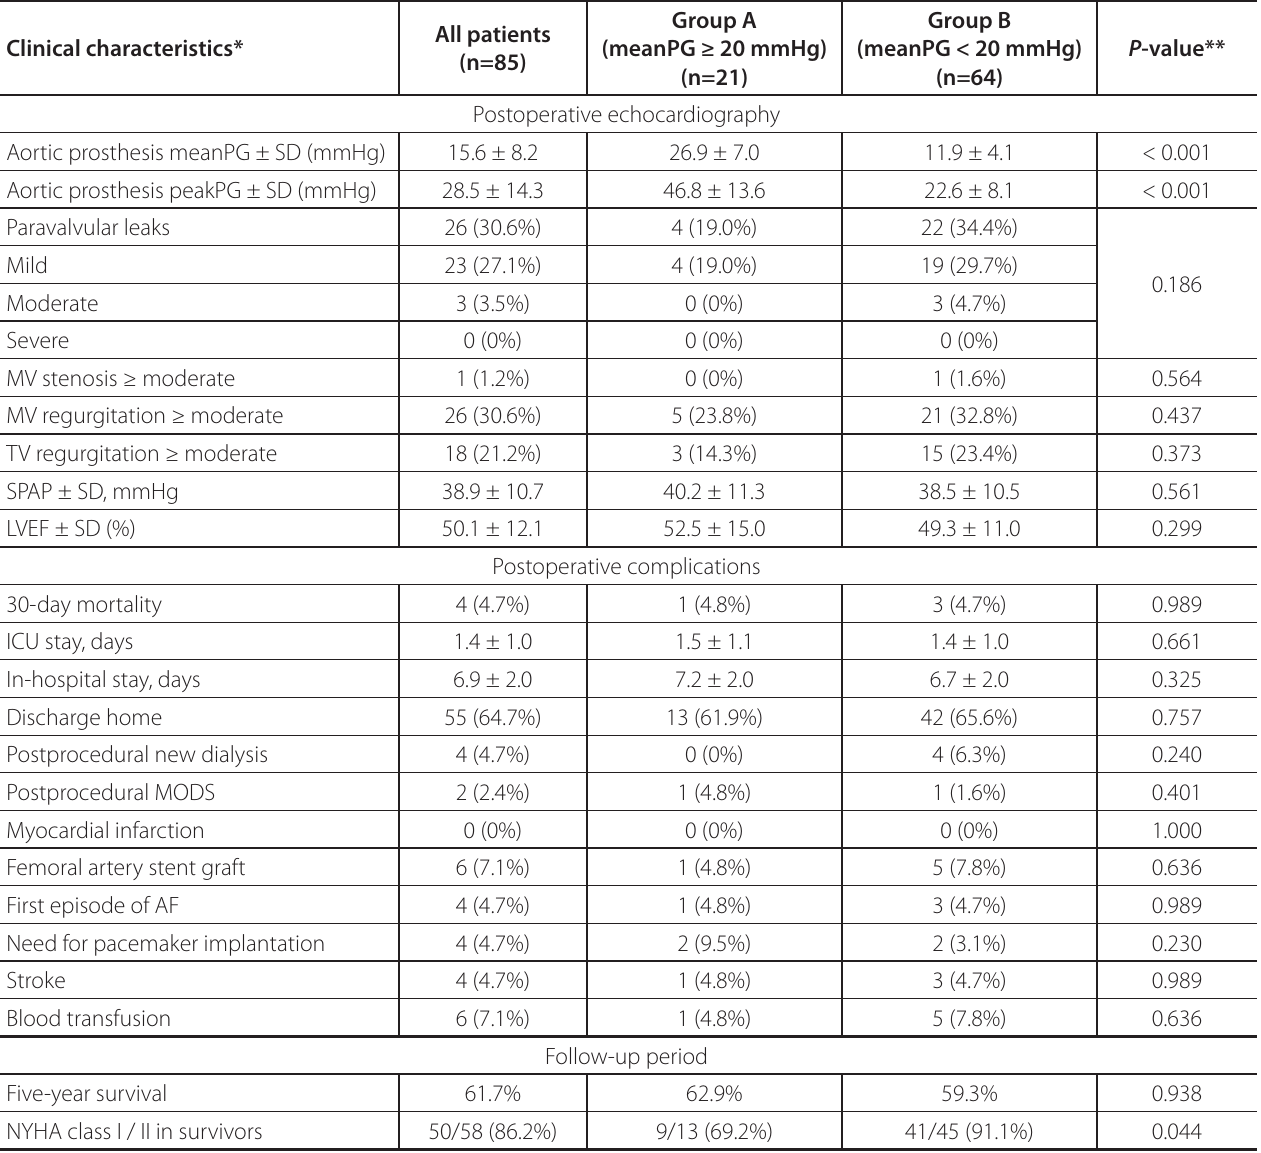
Table 4 . Postoperative outcomes. Clinical